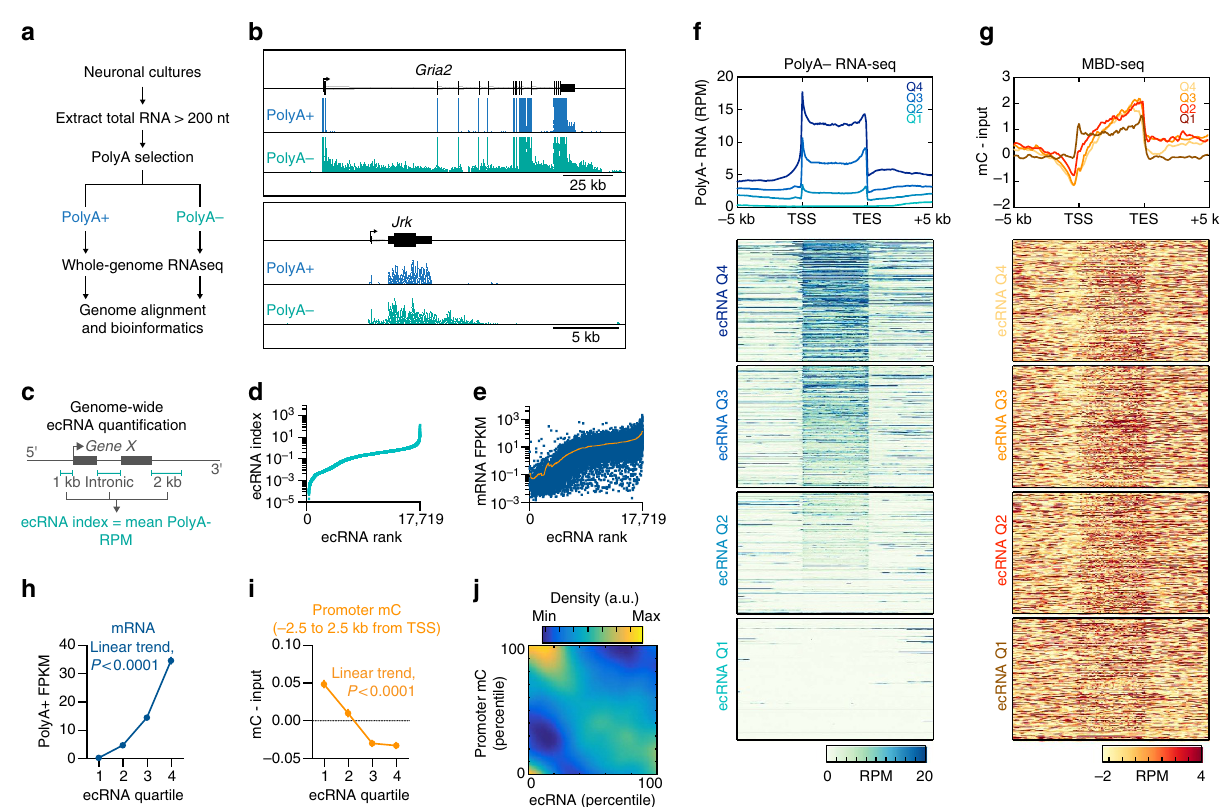
Figure 1 | Genome-wide identification and quantification of ecRNAs from neuronal systems. ( a ) RNA-seq workflow identifies both polyadenylated and non-polyadenylated transcripts from the same neuronal tissue. ( b ) Comparison of PolyA þ and PolyA (cid:2) sequencing from representative gene loci reveals PolyA (cid:2) transcripts arising from intronic and post-TESs. ( c ) Genome wide, extra-coding transcripts were characterized by averaging PolyA (cid:2) reads that mapped to 5 0 (pre-TSS), intronic or 3 0 (post-TES) of a given gene. ( d ) Rank plot of ecRNA index at 17,719 rat genes. ( e ) mRNA expression (PolyA þ RNA- seq) ranked by ecRNA index reveals correlation between ecRNA and mRNA expression. ( f ) Division of ecRNA into discrete quartiles reveals general profile and expression of PolyA (cid:2) RNA transcripts. Data are aligned to transcription start sites (TSS) and TESs. Heatmap shows PolyA (cid:2) transcription from all genes. ( g ) MBD-seq reveals metagenomic DNA methylation profiles, including hypomethylation at TSS and hypermethylation at TES. ecRNA transcription is associated with hypomethylated promoters across the genome. ( h , i ) Genome wide, ecRNA levels are positively correlated with mRNA transcription (( h ) one-way ANOVA, F (3,17715) ¼ 612.5, P o 0.0001) and negatively correlated with promoter DNA methylation (( i ) one-way ANOVA, F (3,17715) ¼ 73.27,